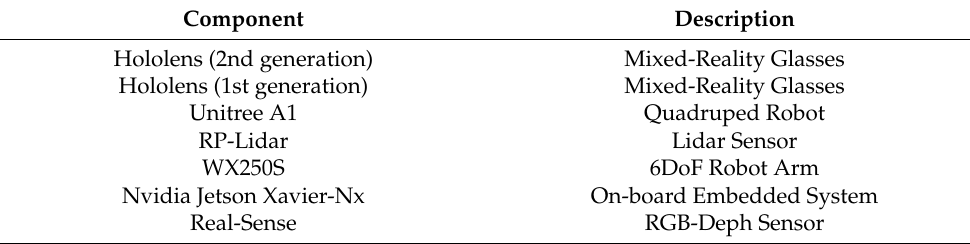
Table 1. Materials for the proposed system